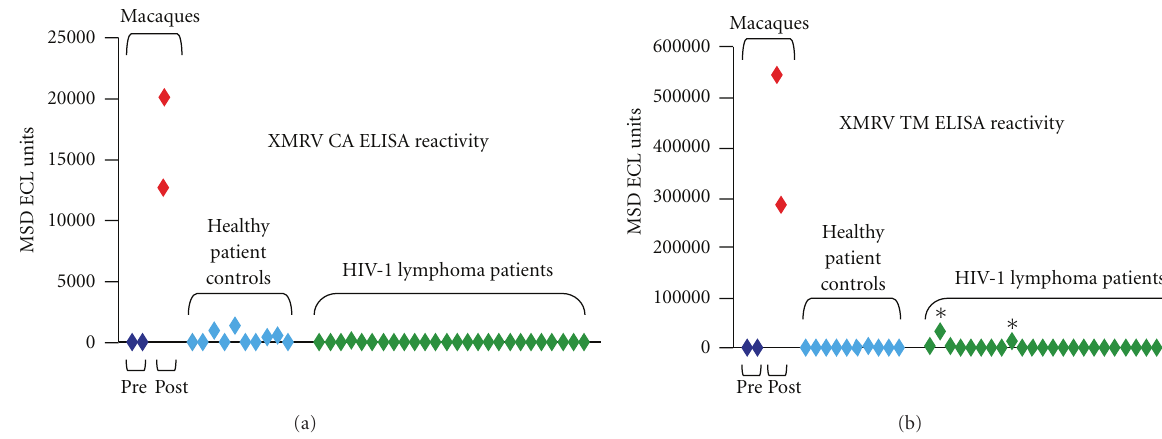
Figure 2: Patient reactivity to XMRV proteins CA and TM. Plasma from the 26 HIV-1 lymphoma positive patients (green diamonds) were assayed by ELISA versus plasma from ten healthy donor controls (light blue diamonds) and two Macaques infected with XMRV pre- (dark blue diamonds) and post- (red diamonds) infection. ∗ indicates two patients with minimal TM